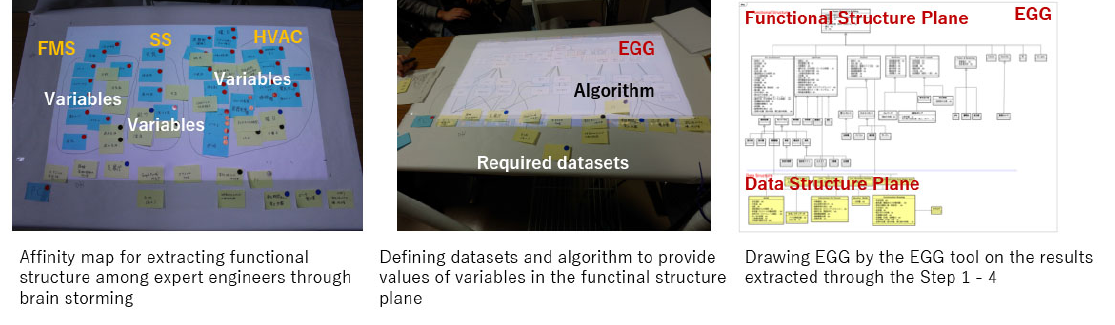
Figure 4. EGG creating process with the brain storming and the affinity